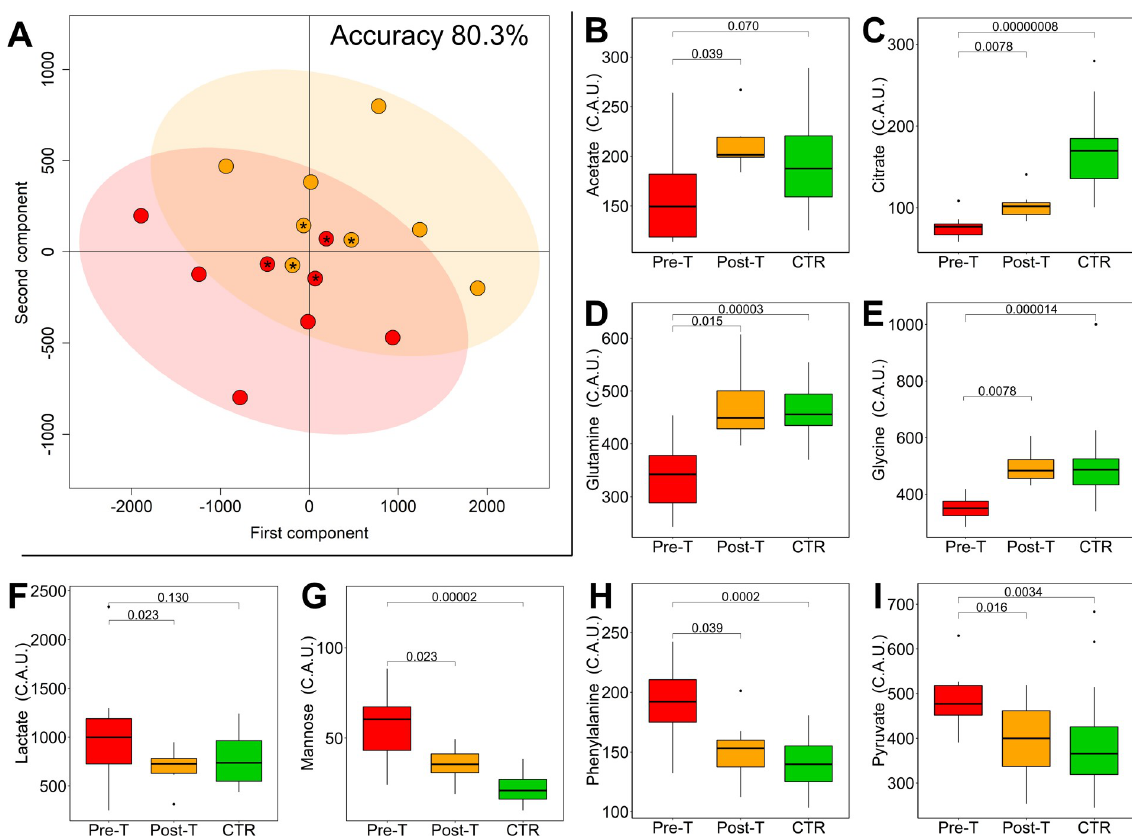
Fig 3. Tocilizumab treatment reverts metabolomic/lipidomic alterations in COVID-19 patients. (A) Score plot (of the first two principal components) and accuracy of the mPLS-DA model discriminating COVID-19 patients at pre- (red dots) and post- (orange dots) tocilizumab treatment using the 21 quantified metabolites. Patients 18, 20 and 21 are marked with � . (B-I) Boxplots of the statistically significant metabolites discriminating of pre- (red) and post- (orange) tocilizumab samples, p-values obtained using Wilcoxon signed-rank test are also reported. Boxplots of controls (green) and the p-values (Wilcoxon-Mann-Whitney test) for the comparison between pre-treatment and CTR are reported. P-values adjusted for FDR are reported in S5 Table.